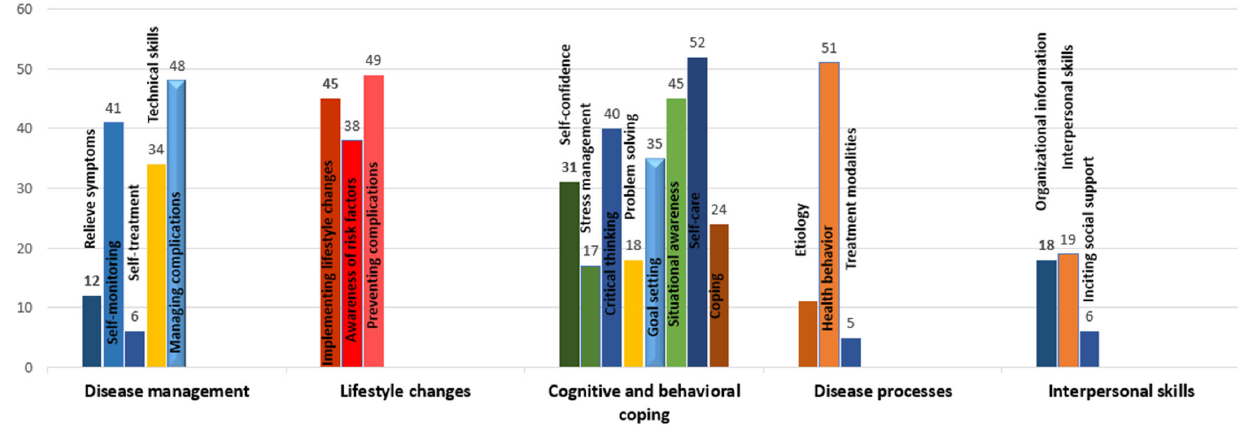
Figure 3. Content and skills for development of TPE